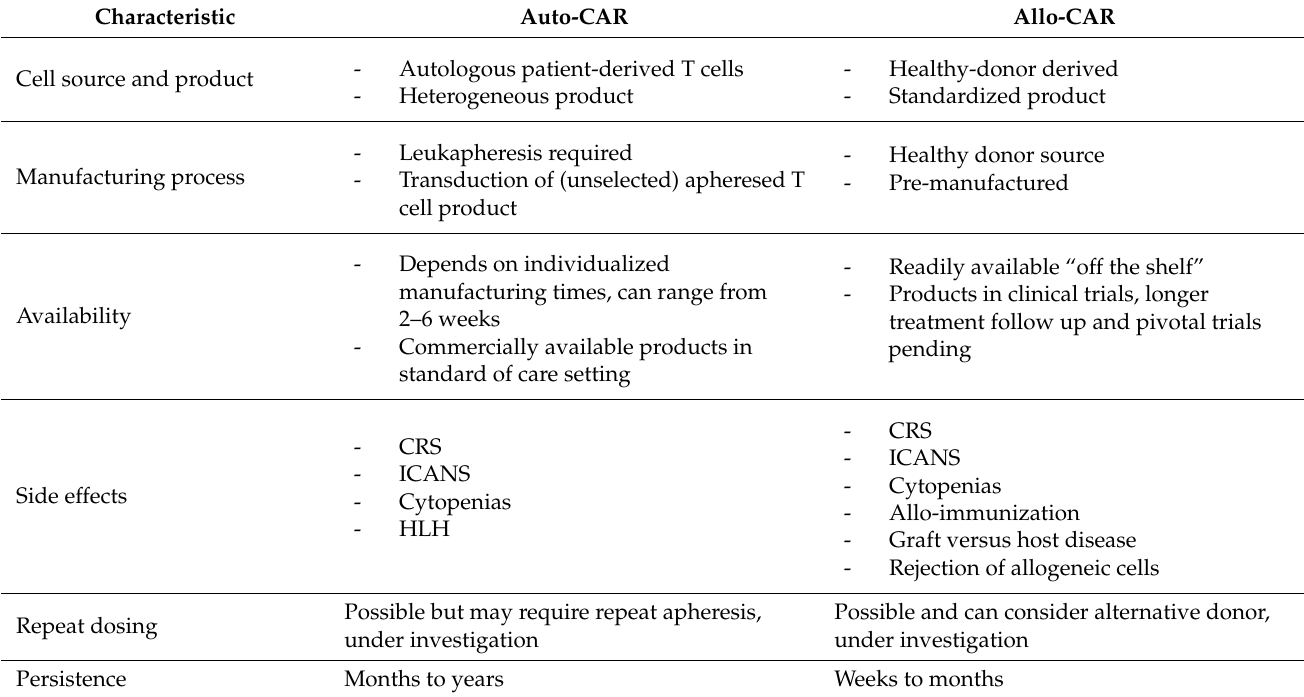
Table 4. Differences between auto-CAR and allo-CAR T cell